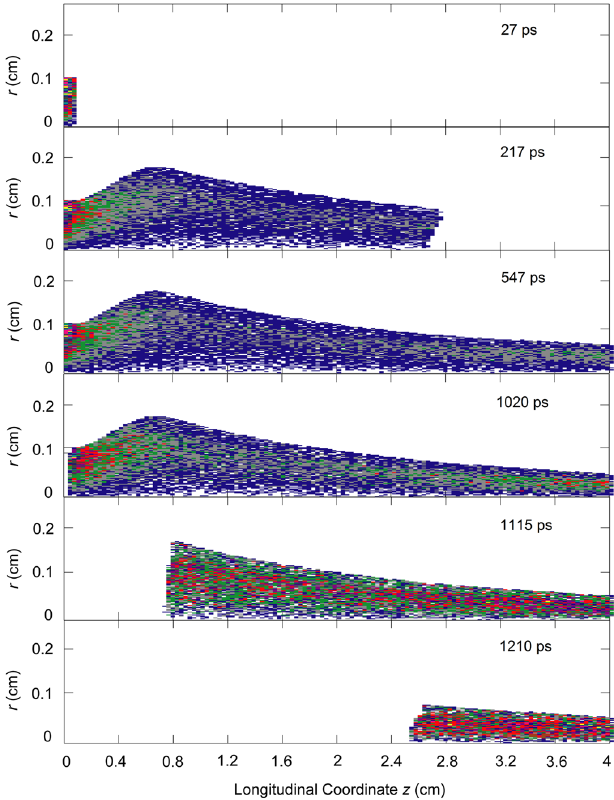
FIG. 28. Snapshots of the electron distributions in the rz plane.